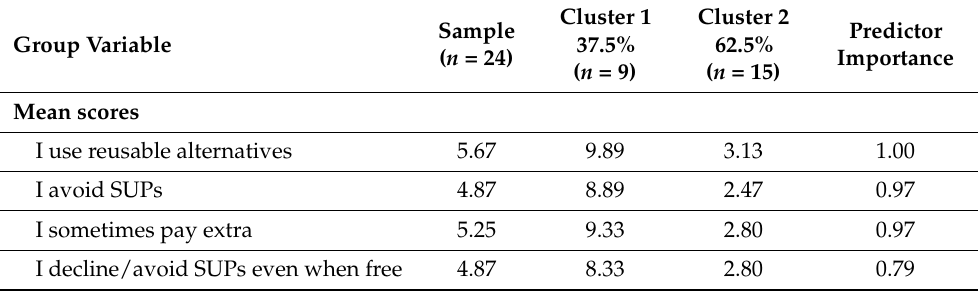
Table 4. SUP behaviour-based clusters of teachers.